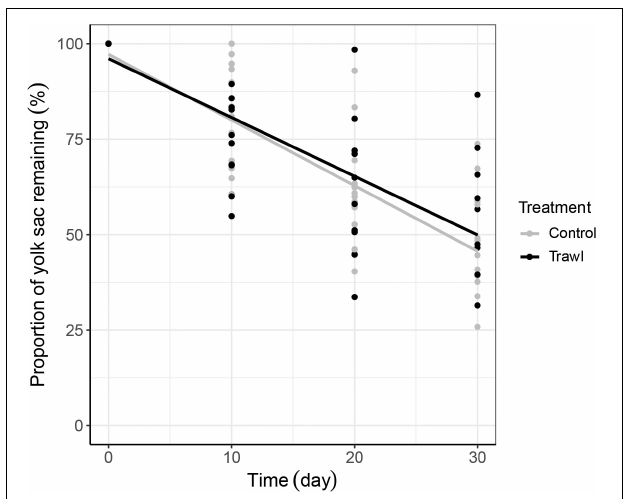
FIGURE 5 | Yolk sac consumption rate. The proportion of neonate yolk sac volume remaining as a percentage (related to initial volume at day 0 = 100%) is plotted against time separately for each maternal Treatment: Control (gray; n = 16) and Trawl (black; n = 11). Points represent original data, and the lines were fitted by linear